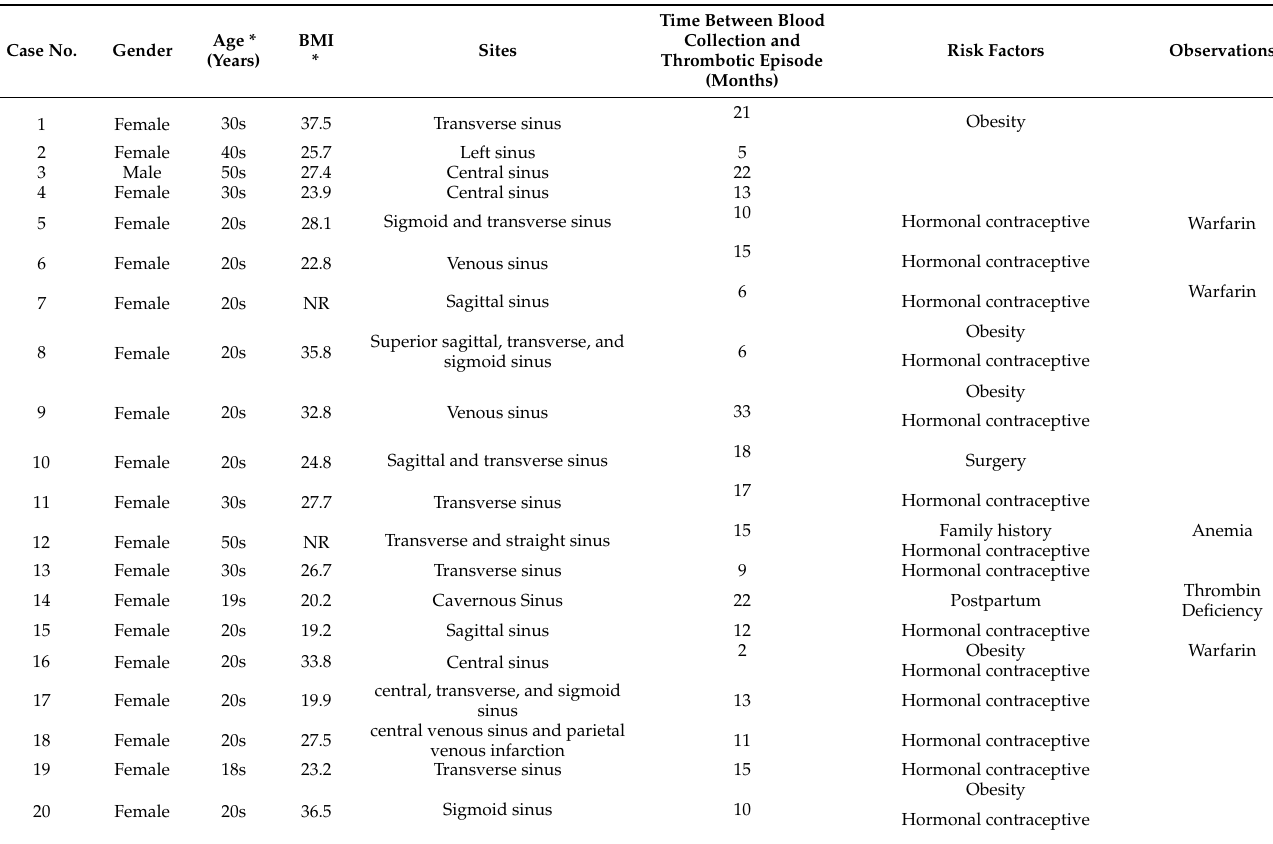
Table A2. Clinical summary of patients with CVT. * Age and body mass index (BMI) at thrombosis moment; BMI: above (25–29.99),